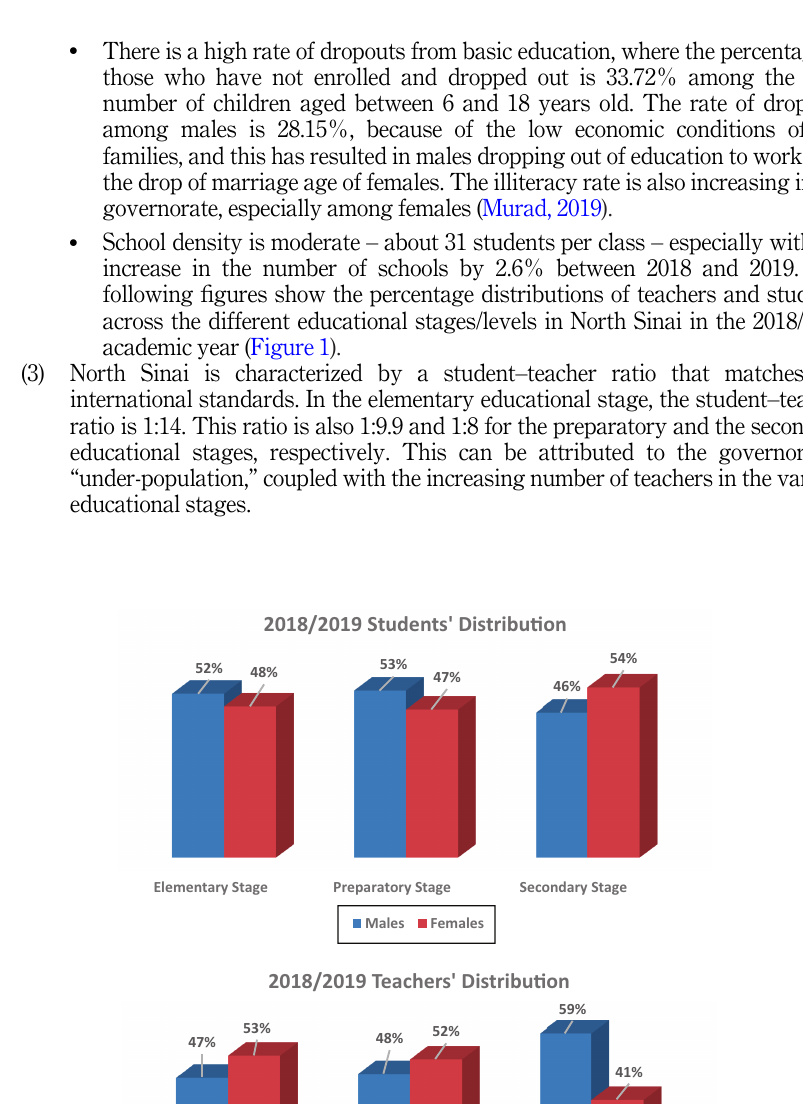
Figure 1. Percentage of distribution